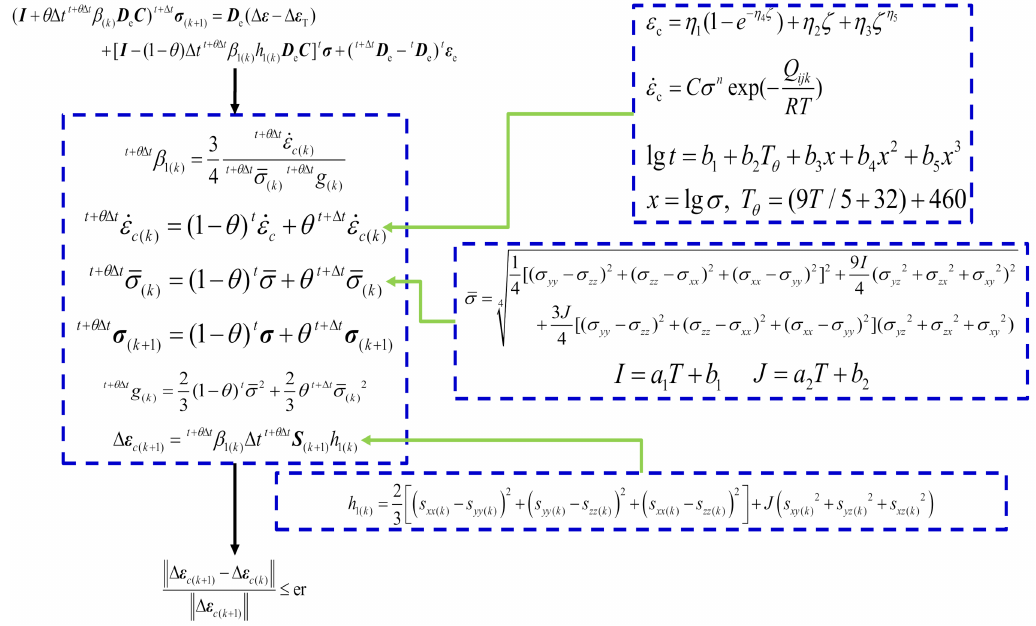
Figure 9. Subroutine calculation flow